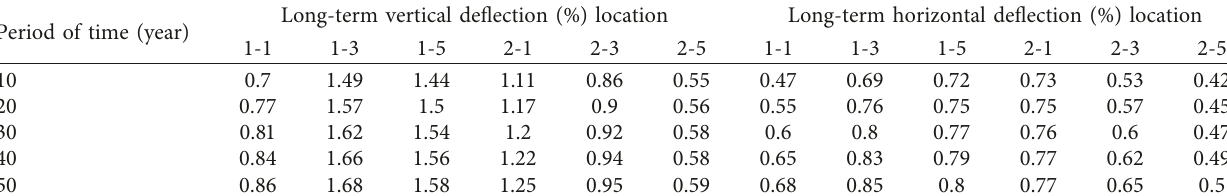
Figure 8: Ring deflection of GFRP pipe versus pipe stiffness. Table 5: Predicted results of long-term ring deflection of